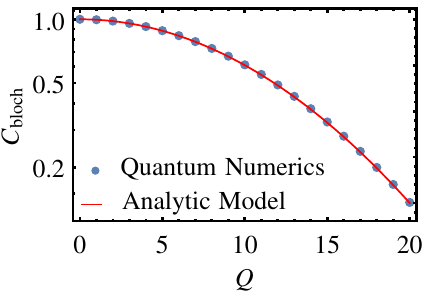
FIG. 13. Contrast loss (on a logarithmic scale) due to the finite size of the Bloch sphere for N = 100